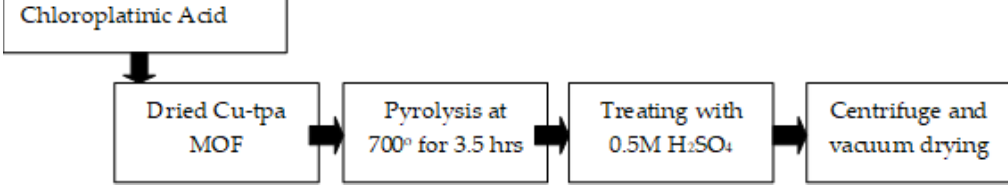
Figure 9. Systematic procedure for the synthesis of CuPt/NC catalyst.